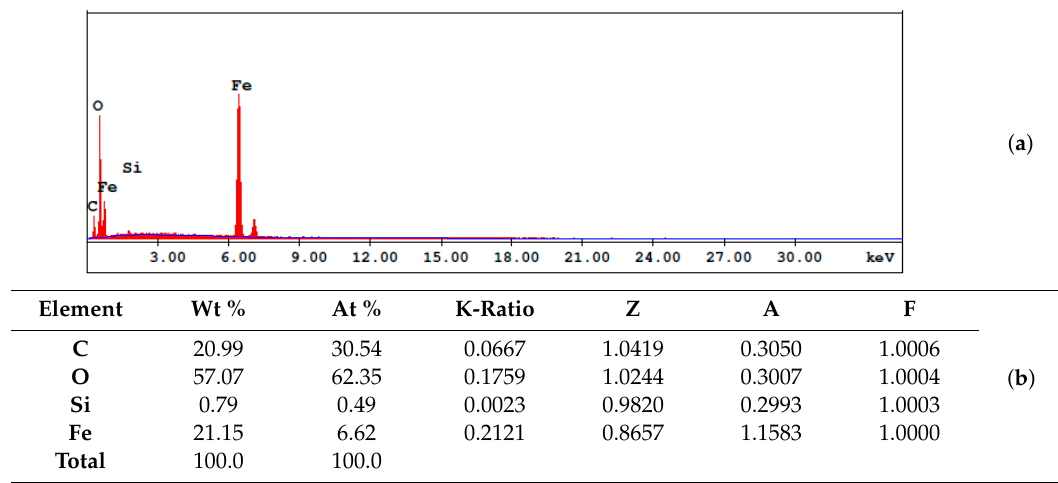
Table 2. ( a ) EDAX ZAF spectrum and ( b ) element quantification of the friction welded rod.